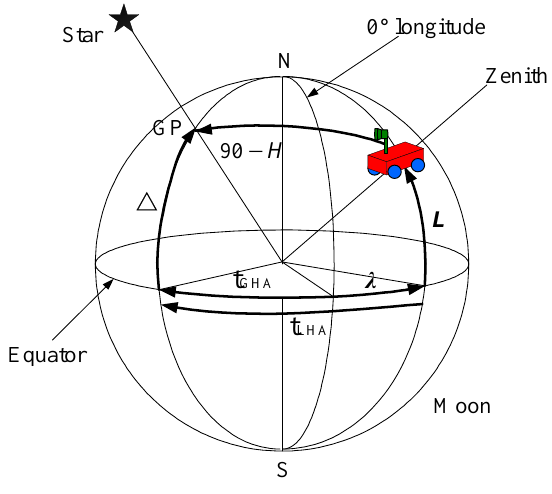
Figure 2. Parameters in the Moon fixed